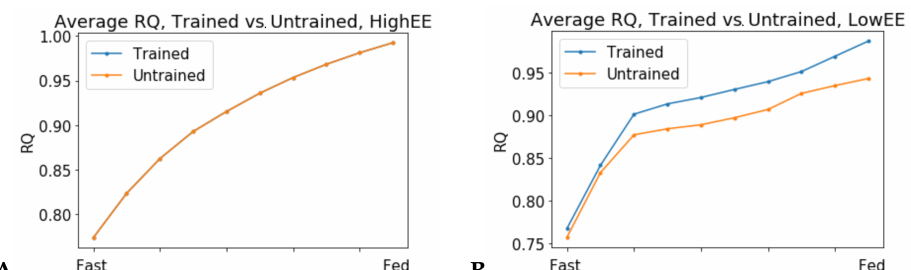
Figure 5. Simulations in low energy expenditure conditions show heterogeneity of individualized models’ predictions. RQ values predicted by a set of 24 patient-derived models of skeletal muscle metabolism. ( A ) High energy expenditure conditions (ATPH bound = 1000 mM/gDw/h). All models predict the same RQ values during the fast to fed transition and have overlapping RQ profiles. ( B ) Comparison of trained vs. untrained subgroups. Low energy expenditure condition (ATPH upper bound = 35 mM/gDw/h). In this condition, untrained models predicted lower RQ values on average and low variability between the fast and fed conditions than trained models. These two phenotypes are associated with metabolic